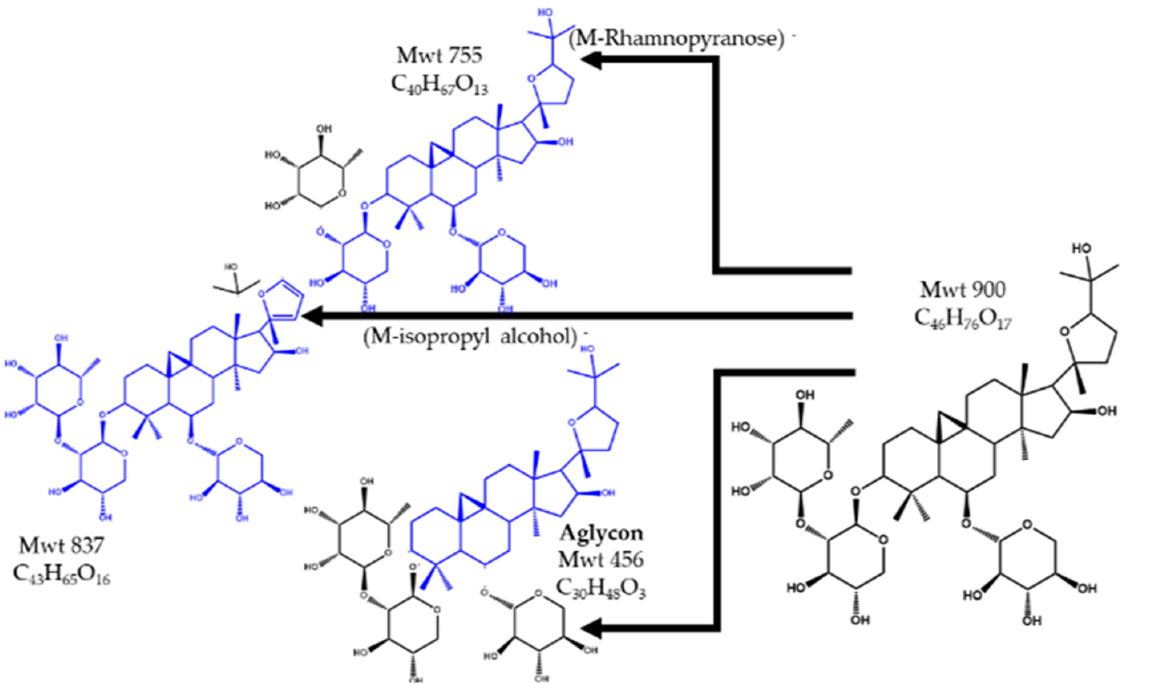
Figure 7. The structure and fragments of Astrasieversianin XV.